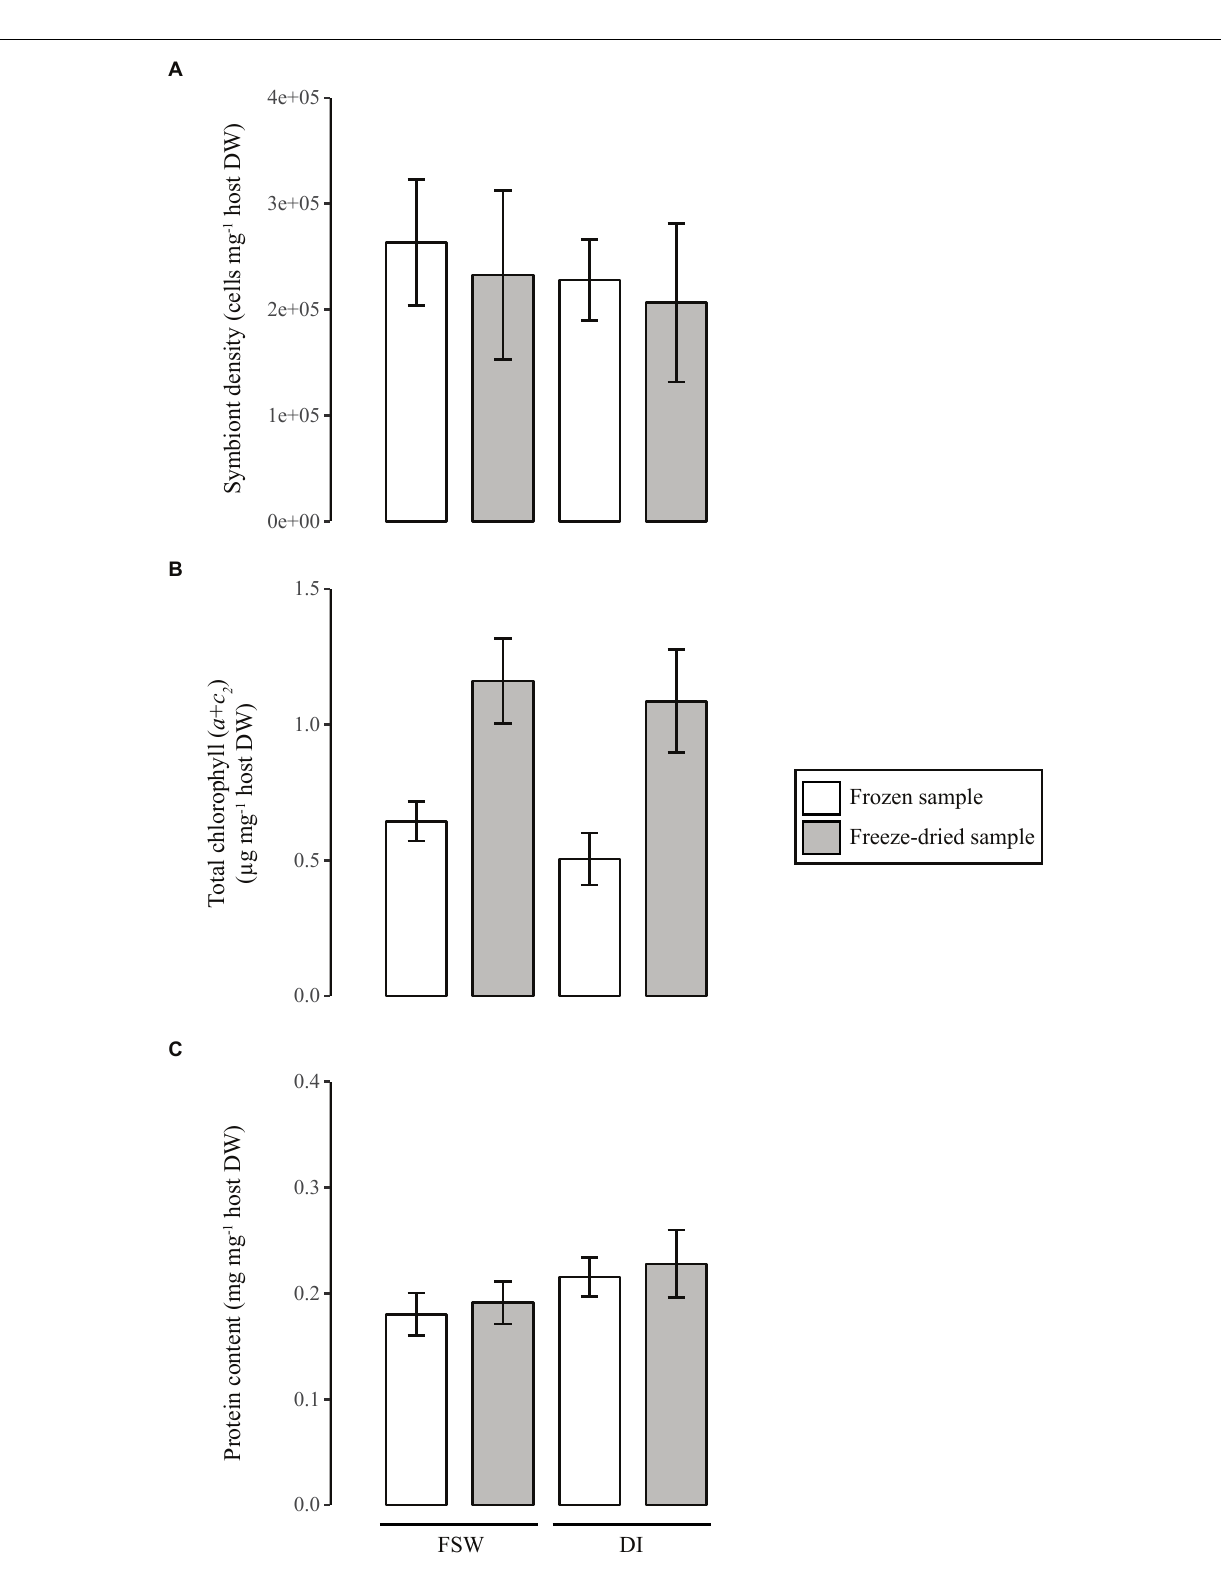
FIGURE 2 | Tissue parameter quantification in soft corals using different sample processing techniques. Samples were either processed frozen or after freeze-drying and homogenized in filtered seawater (FSW) or Milli-Q water (DI). All tissue parameters ( Symbiodinium density, A ; chlorophyll, B ; and protein content, C ), are normalized to host dry weight. Error bars represent standard deviation of five samples.